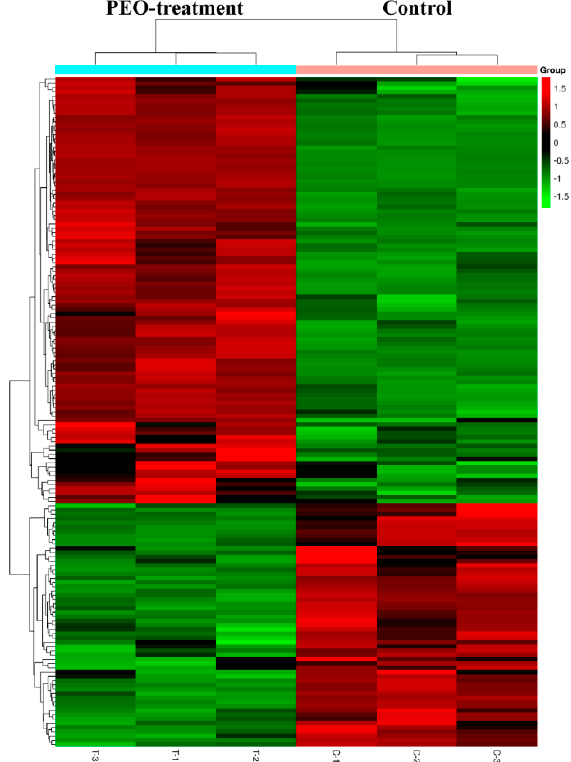
Figure 8. Heat map of DEGs with fold change expression > 1.5. MGC-803 cells were treated with 50 µ g / mL PEO or control for 24 h ( n = 3). Rows represent genes and columns represent samples. Red blocks represent high and green blocks low expression relative to comparison cells.